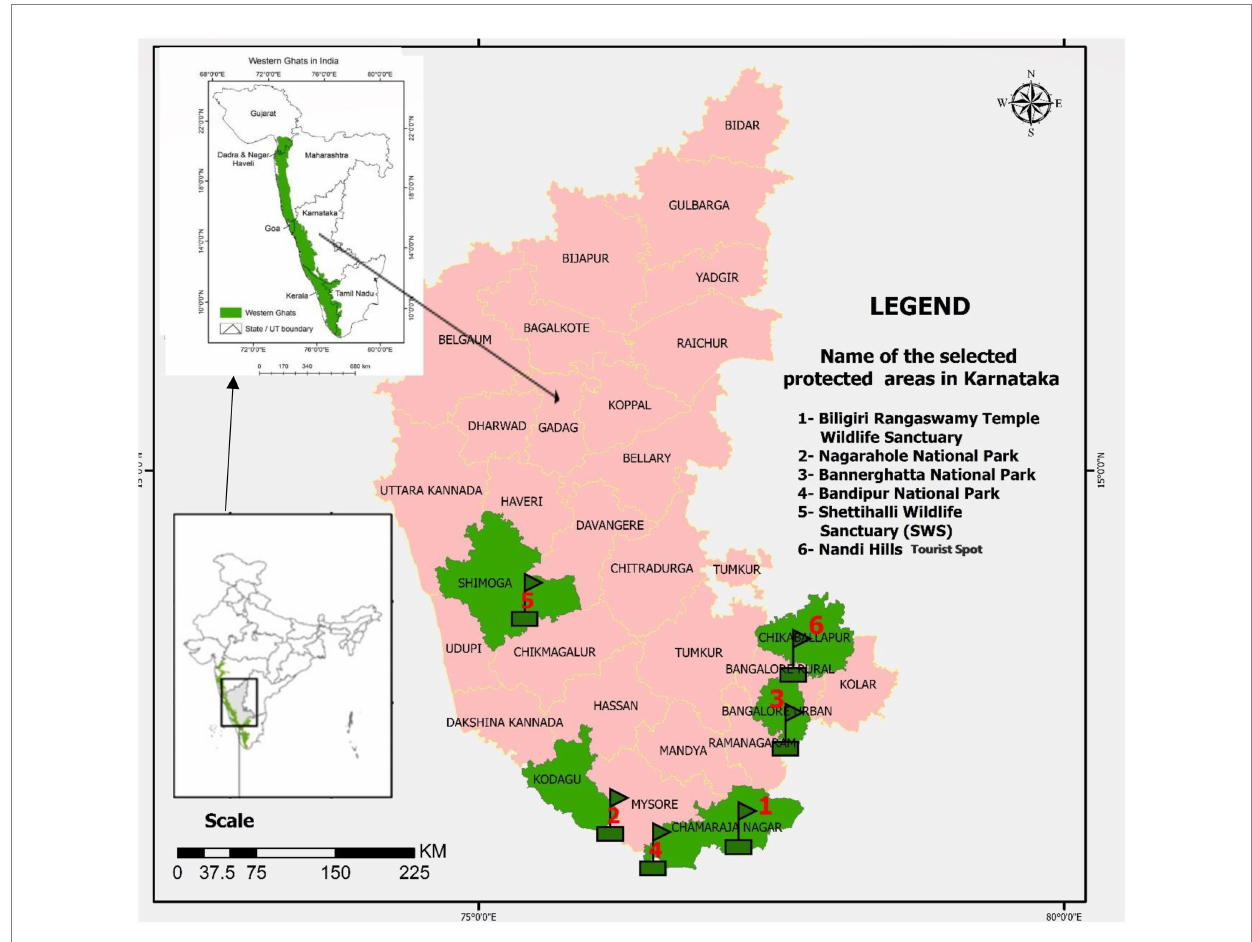
FIGURE 1 Western Ghats study areas in the Indian state of